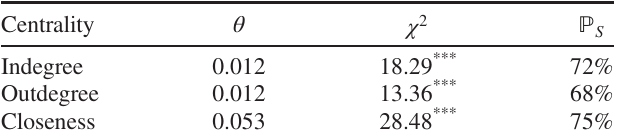
TABLE VII. The threshold value ( θ ) for each centrality measure as determined by maximization of the mutual informa- tion, its significance level measured by the chi-square test, and the probability of successfully inferring the persistence based on centrality ( P S ). Significant p values are marked with an